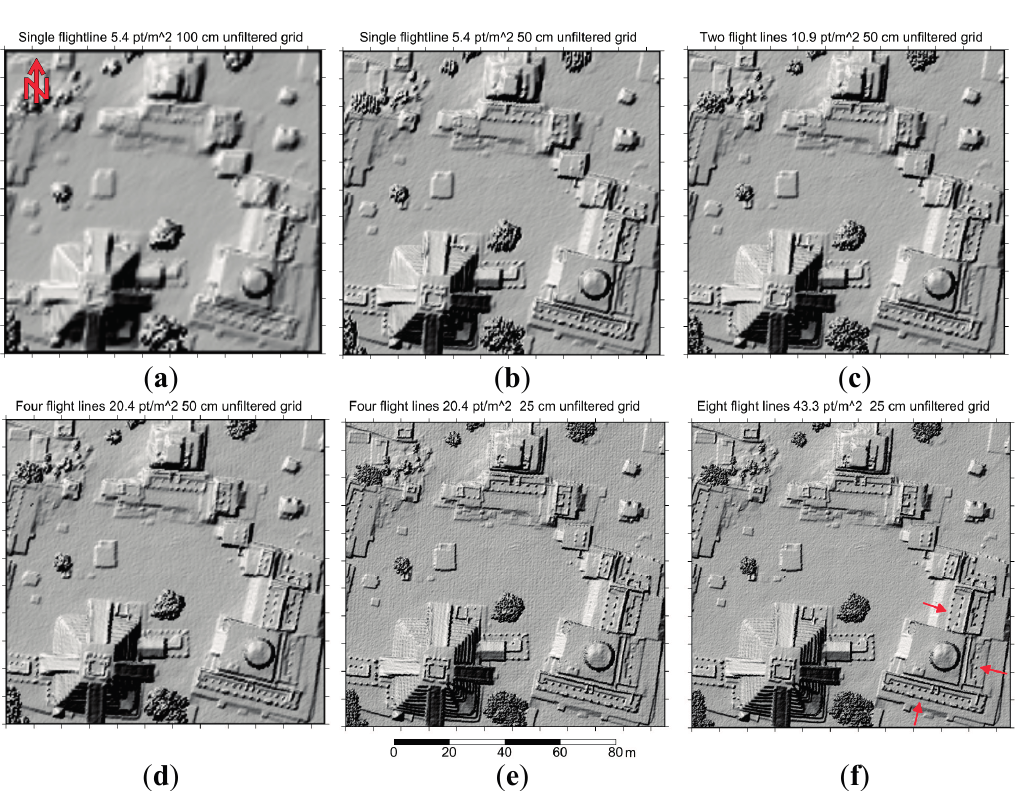
Figure 10. Comparative illustration of the relationship between point cloud return density and raster resolution. ( a ) 1-m DSM from 5.4 returns/m 2 ; ( b ) 0.5-m DSM from 5.4 returns/m 2 ; ( c ) 0.5-m DSM from 10.9 returns/m 2 ; ( d ) 0.5-m DSM from 20.4 returns/m 2 ; ( e ) 0.25-m DSM from 20.4 returns/m 2 ; ( f ) 0.25-m DSM from 43. returns/m 2